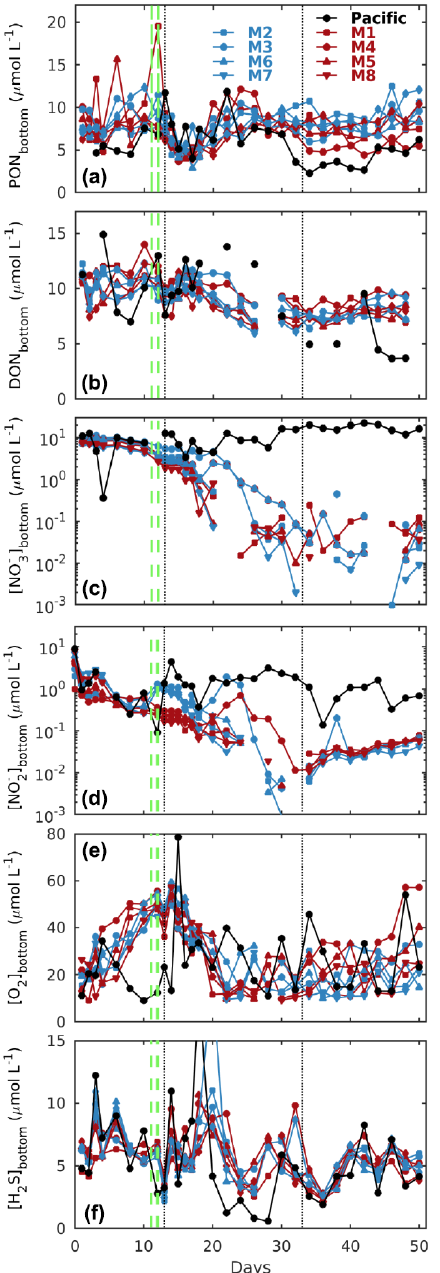
Figure 3. Temporal evolution of depth-integrated bottom layer (a) PON, (b) DON, (c) nitrate (NO − ), and (d) nitrite 3 (NO − ), together with CTD-derived (e) oxygen (O 2 ) and (f) hydro- 2 gen sulfide (H 2 S) concentrations at the Niskin sampling depth in the mesocosms (M1–M8) and the surrounding Pacific. Blue and red denote the low N / P and very low N / P deep water additions, respectively (see Sect. 2.2 for details). The dashed green lines denote deep water additions on days 11 and 12, while the dotted black lines denote additions of a brine solution to the bottom layer to increase salinity, strengthen stratification, and reduce mixing. See Sect. 2 for details.